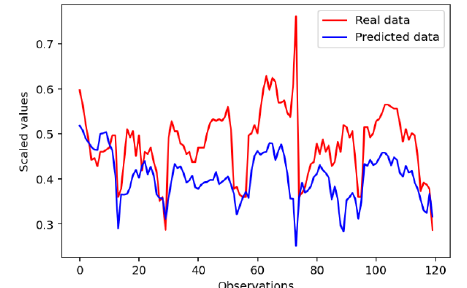
Figure 10. Real (red) and predicted (blue) data of the unseen dataset.